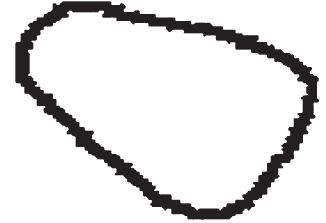
Fig. 7. Illustration of the original convex hull